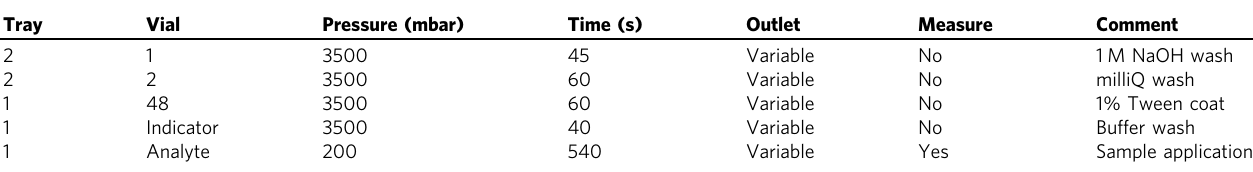
Table 1 Experimental parameters for Cap fl ex analysis of Ddx4n1 on the FIDA 1 instrument.